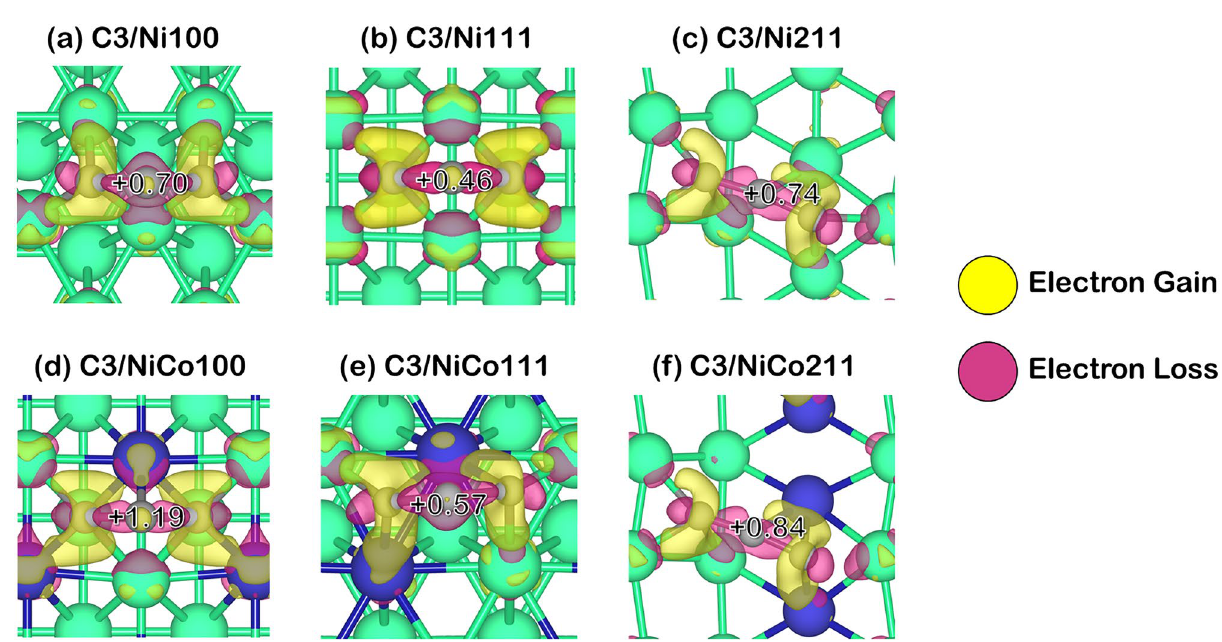
Figure 8. The charge density difference corresponding with Bader charge changes of C3 coke species adsorption on Ni and NiCo surfaces with an isovalue of ± 0.015 |e|/Å 3